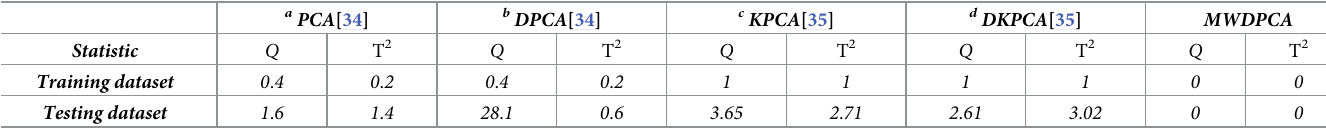
Table 2. Comparison of FAR for MWDPCA with other